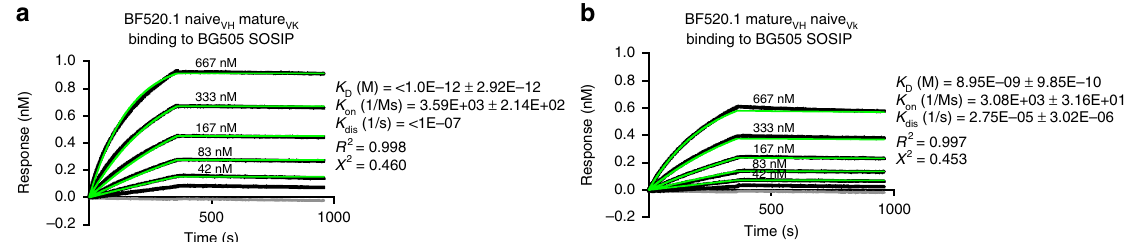
Fig. 3 Contribution of kappa chain maturation to HIV binding. a , b BLI representative reference-subtracted sensorgrams for each interaction between the BG505.SOSIP.664 (ligand) and BF520.1 naive VH mature VK ( a ) and mature VH naive VK ( b ) (analytes). IgG concentrations ranged from 667 to 42 nM. The gray lines show 0 μ M IgG. K D , K on , and K dis are shown from best fi tting (green lines) to a 1:2 bivalent analyte model of